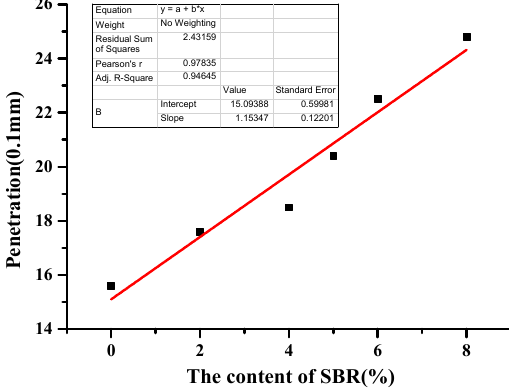
Figure 6. Fitting curves of SBR content and penetration.